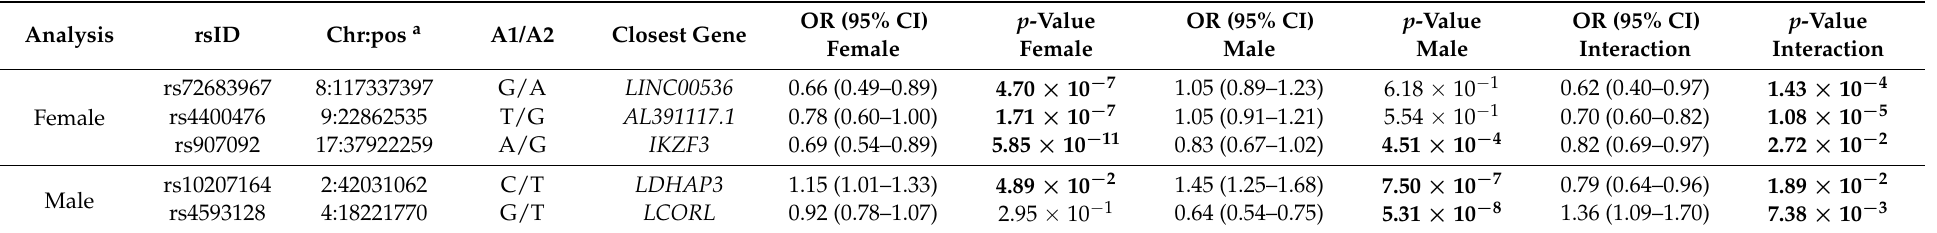
Table 3. Summary of independent variants identified in the stratified analyses ( p ≤ 1.9 × 10 − 6 ), and their association results in the interaction